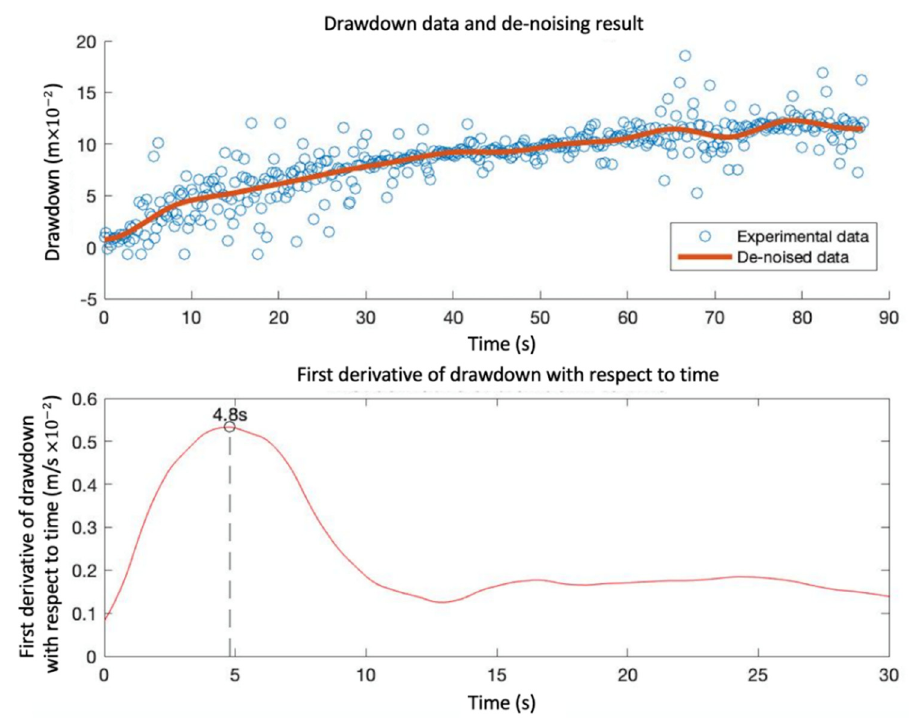
Figure 14. Data processing of a set of field data.